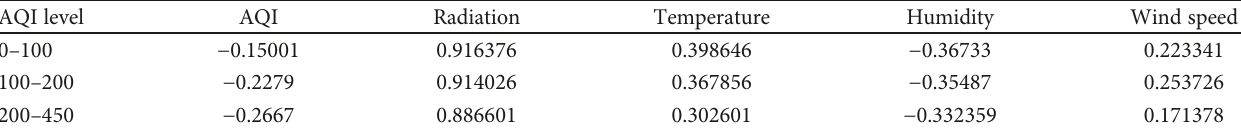
Table 1: Pearson correlation between PV power and meteorological parameters under di ff erent AQI level.